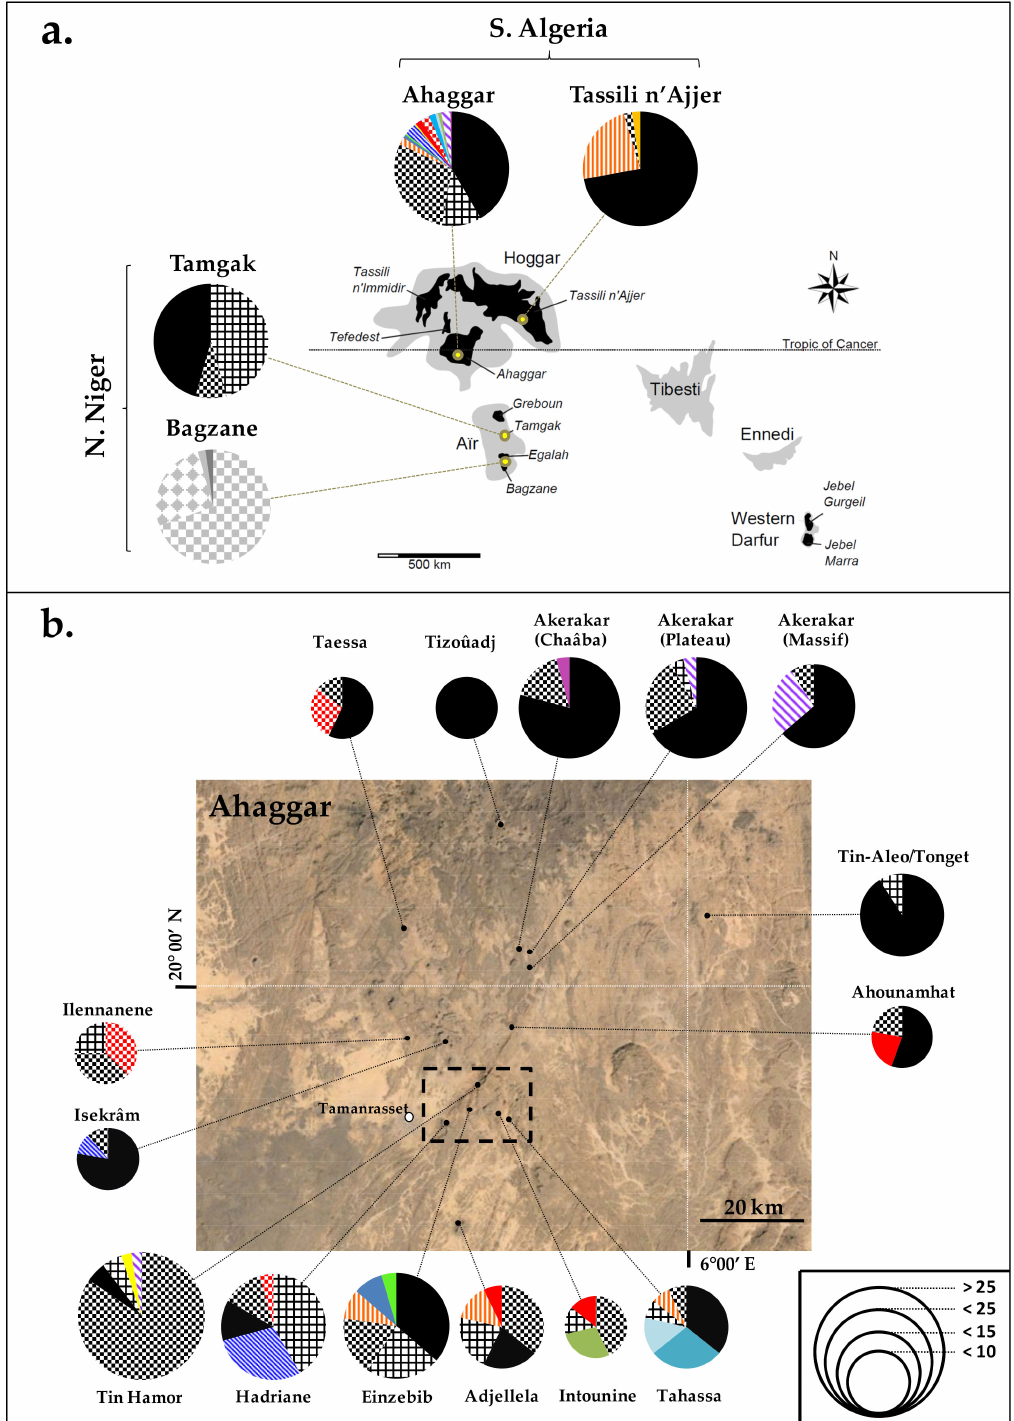
Figure 3. Distribution of chlorotypes in the Laperrine’s olive of Central Sahara: ( a ) in each massif sampled in Hoggar (Algeria) and Aïr (Niger), and ( b ) at each locality sampled in Ahaggar. In ( a ), the main Saharan mountains are represented in grey with the Laperrine’s olive range in black [20]. In ( b ), the area defined by the dashed lines corresponds to the most sampled area and is referred to as “Adrar Heggheguene”. The size of pie charts is proportional to subpopulation size with the scale defined by the number of individuals